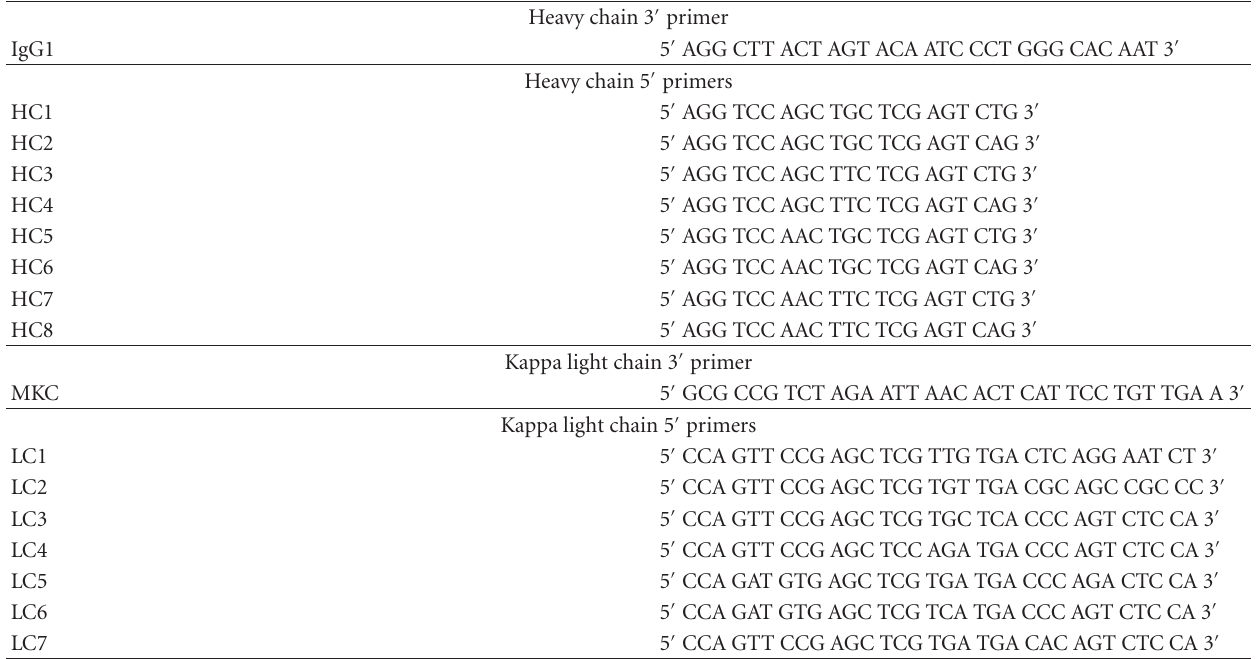
Table 1: Primers used to amplify antibody variable